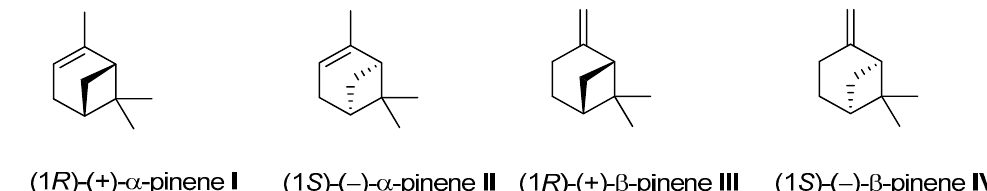
Figure 17. Monoterpene-based 1,2,4- and 1,3,4-oxadiazole derivatives.